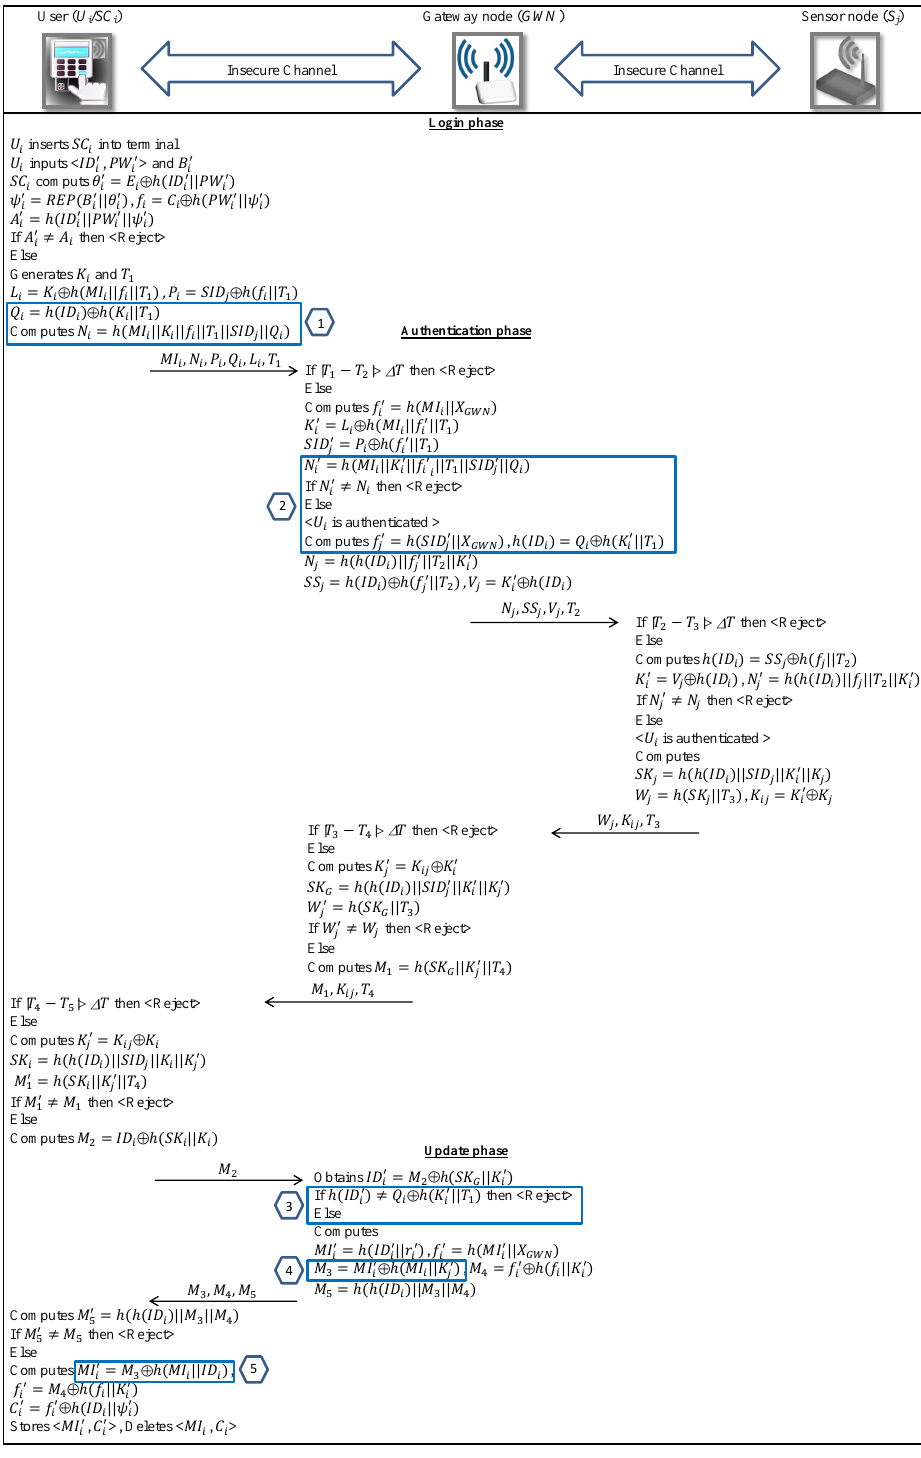
Figure 3. Modified Amin et al.’s authentication and key agreement phase. Changes are highlighted by boxes in the proposed